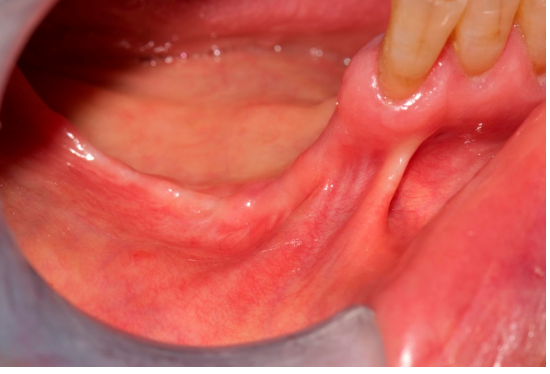
Figure 8. Three-month follow-up after surgical treatment for medication-related osteonecrosis of the jaws (MRONJ): complete clinical healing was achieved both in mandible and maxilla.